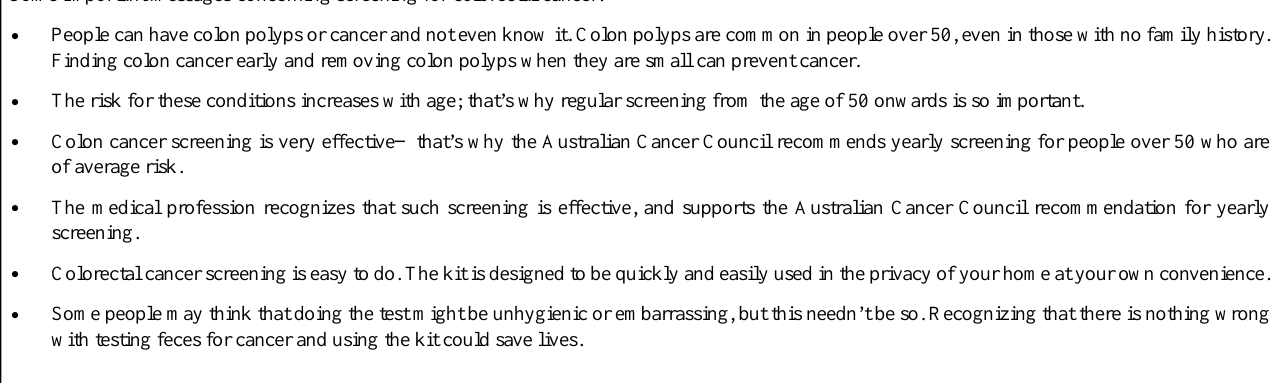
text that progressed according to the table of contents. The Web group received the same material but as a series of headings, tabs, and hyperlinks. Web pages were designed to reflect issues of vision and cognition needs of older users; for example, the Textbox 1. Generic Information Statements to Encourage Colorectal Cancer